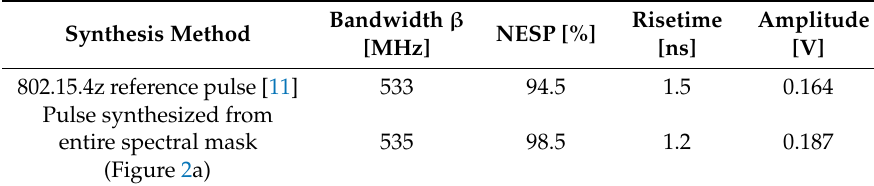
Table 1. The synthesis quality parameters.